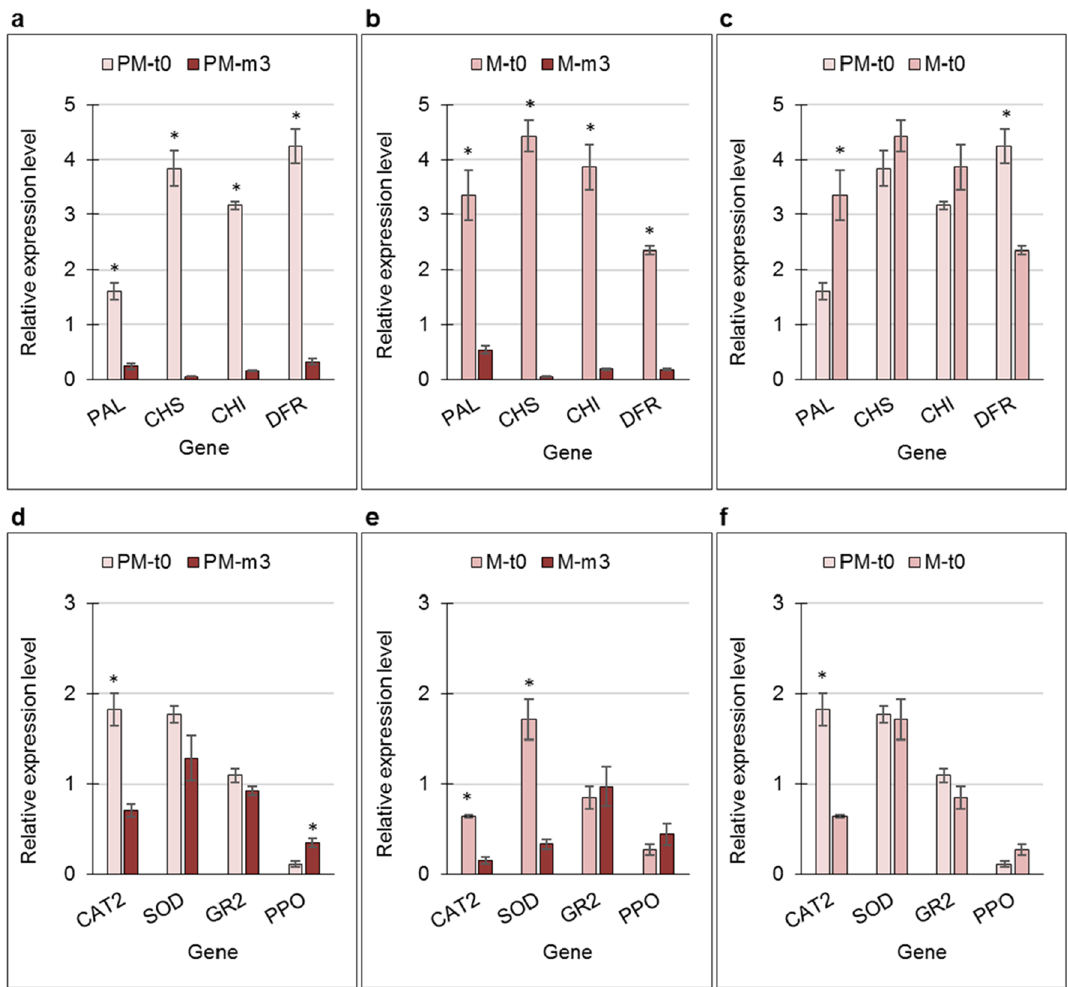
Figure 6. Expression of key anthocyanin-biosynthesis genes ( a – c ) and antioxidant-related genes ( d – f ) in the skin of premature (PM) and mature (M) fruit at harvest (t0), and after 3 months in storage (m3). Comparisons were made between t0 and m3 for PM ( a , d ) and for M fruit ( b , e ), and between t0 of PM and M fruit ( c , f ). Values are averages of three biological replicates ± SE. Asterisks indicate significant difference among means for each gene by Student’s t -test ( P <